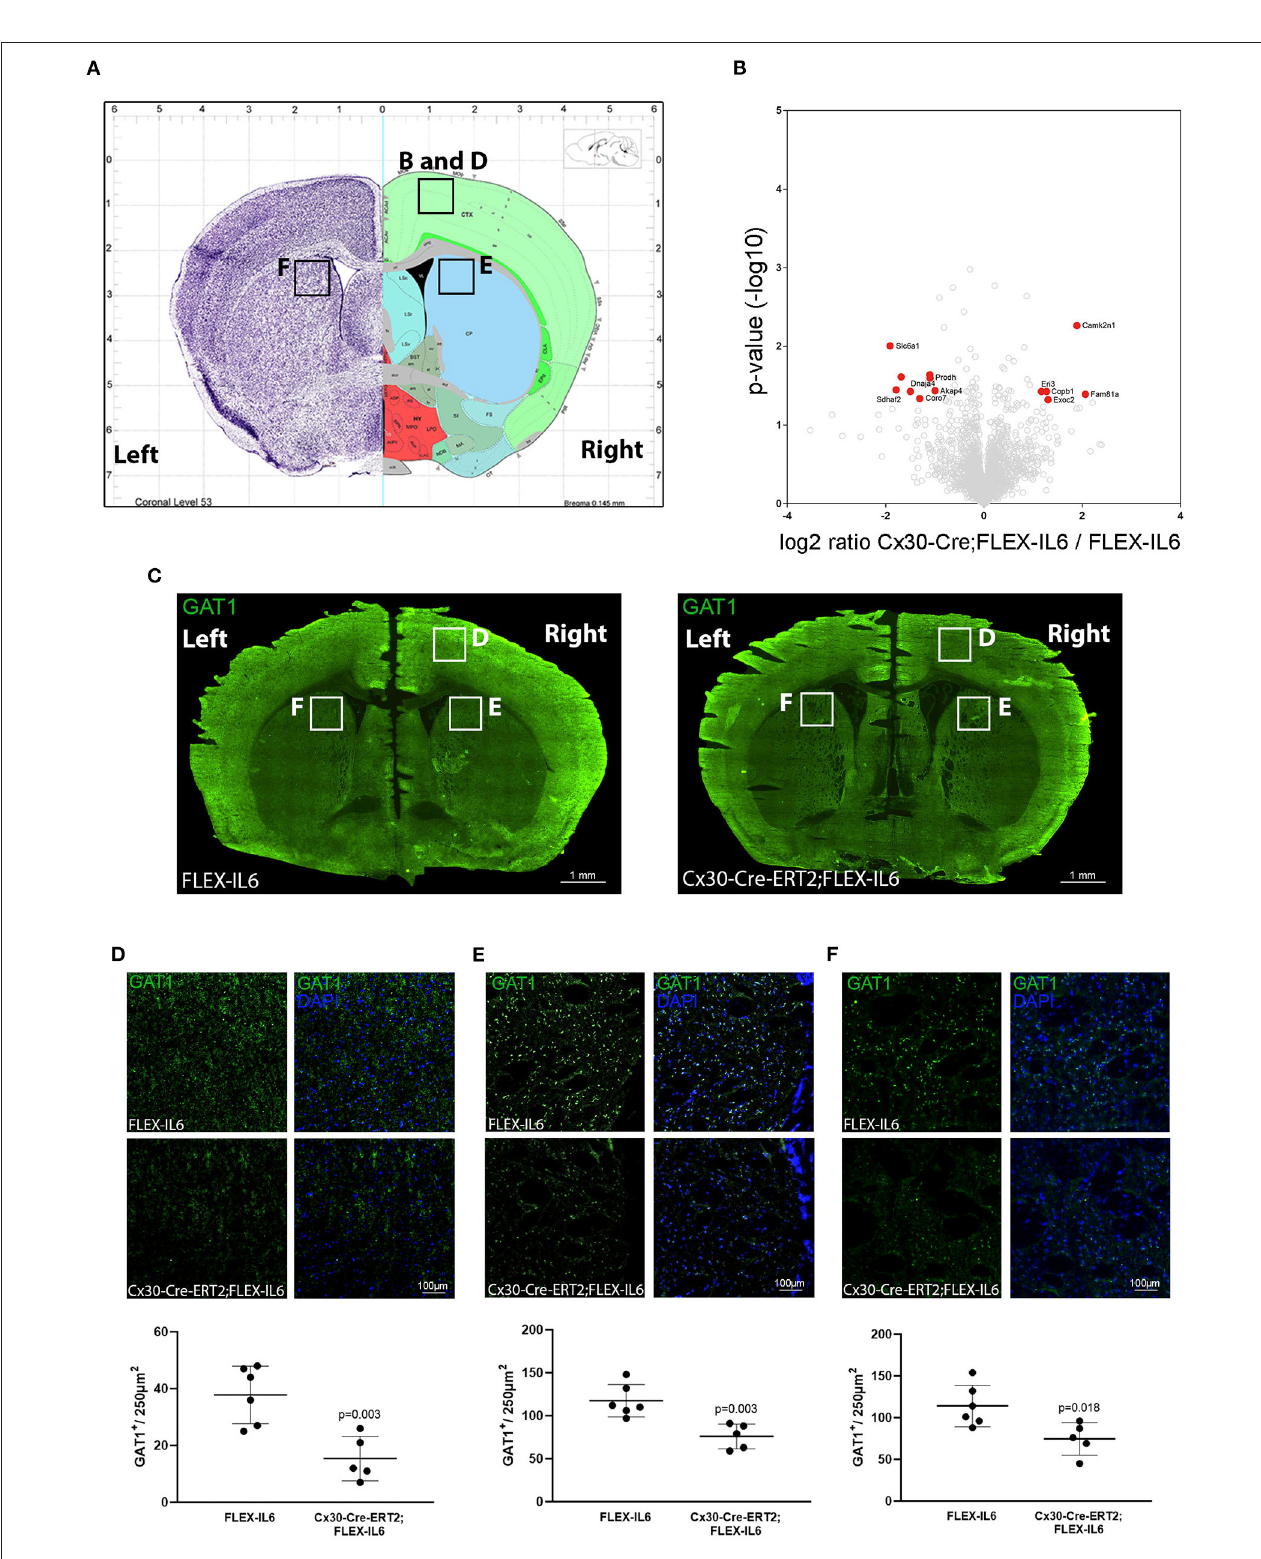
FIGURE 5 | Paracrine IL − 6 induces changes of the proteome in the contralateral motor cortex. (A) Location of the dissected tissue and histological analysis (Allen mouse Brain Atlas). A part of the motor cortex was isolated on the contralateral hemisphere and the proteome changes were analyzed. (B) The volcano plot